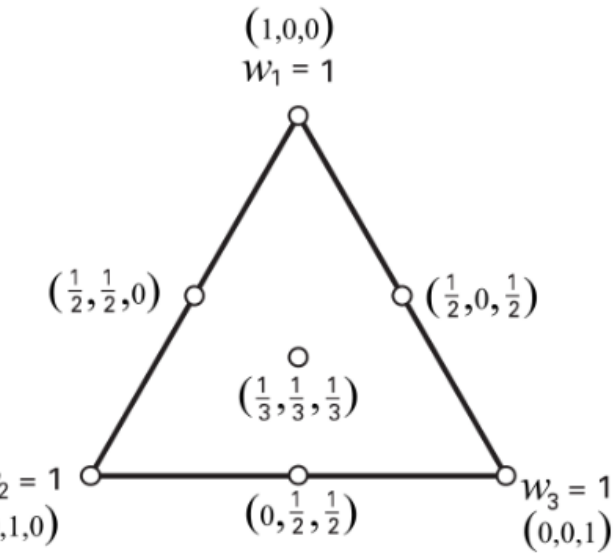
Figure 8. Mixture DOE example: Simplex Design with three factors. Source: own authors.